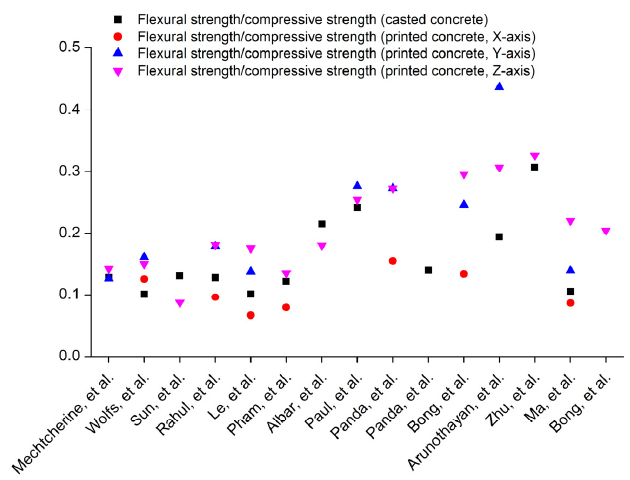
Figure 13. A comparison of the ratio of flexural strength to the compressive strength Figure